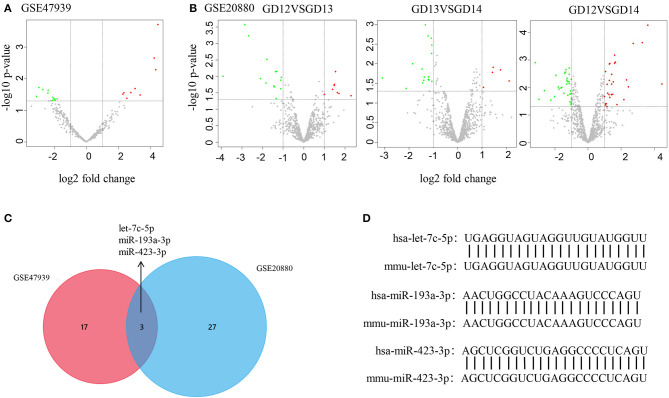
DEM identification by bioinformatics |analysis. (A,B) Volcano plot shows DEMs in GSE47939 and GSE20880. Red, green, and gray color indicates relatively high, low, and equal expression of miRNAs, respectively. GD, gestational days. (C) Venn diagram shows the overlapping DEMs in GSE47939 and GSE20880. (D) Nucleotide sequence comparison between humans and mice for the three overlapping DEMs.